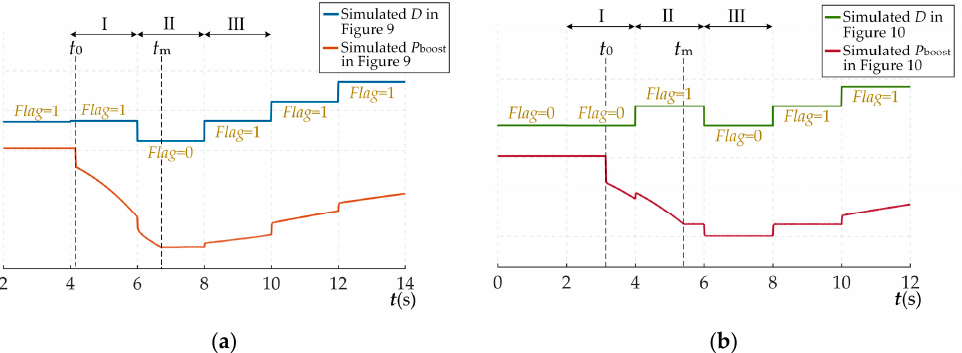
Figure 14. When P&O is selected as the MPPT algorithm, the variations of simulated D and P boost in ( a ) Figure 9 and ( b ) Figure 10.